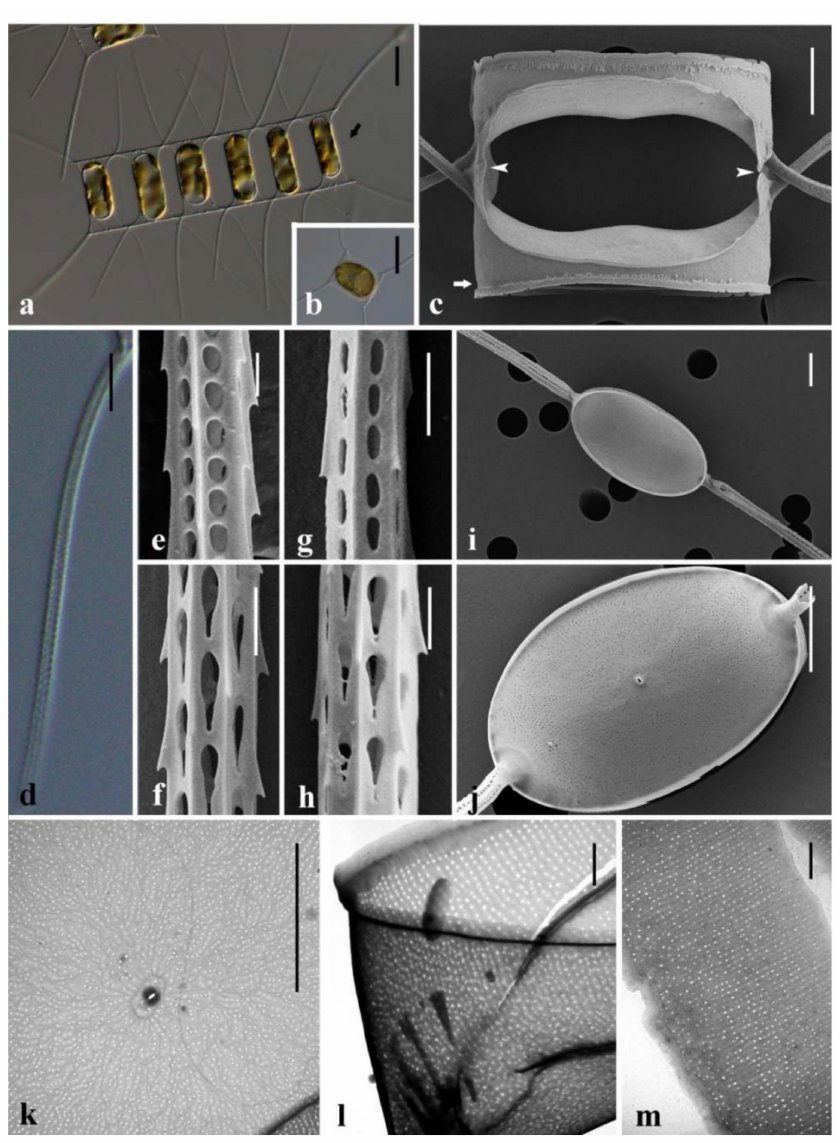
Figure 2. LM ( a , b , d ), SEM ( c , e – j ) and TEM ( k – m ) micrographs of vegetative cells of Chaetoceros macroelegans sp. nov., strain MC785. ( a ) Chains in broad girdle view, showing protrusions on terminal valve (arrow); ( b ) solitary cell; ( c ) sibling intercalary valves showing aperture, overlapping silica ear-like structures (arrowheads) and furrow above the basal ring of mantle (arrow); ( d ) terminal seta under LM, showing visible setae poroids; ( e – h ) setae structure, showing round-oval and tear- shaped poroids on terminal ( e , f ) and intercalary setae ( g , h ), respectively; ( i ) intercalary valve view; ( j , k ) terminal valves; ( l ) parallel rows of poroids on the mantle; ( m ) detail of bands. Scale bars: ( a , b ) 20 µ m; ( c , d , i – k ) 5 µ m; ( e – h , l , m ) 1 µ m. Diagnosis : Straight chains, sometimes solitary cells. Normally 4–10 chloroplasts in each cell. Apical axis 12.6–39.7 µ m. Pervalvar axis 11.3–28.4 µ m. Height of aperture 6.3–12.6 µ m. Rectangular cells in girdle view. Central annulus, radiating costae and scattered poroids on valve face and mantle. Elliptical–hexagonal apertures. Setae Brunel I type. Short setae base or absent. Sibling setae intersect outside chain border without fusing. Tear-shaped and round-oval poroids on intercalary and terminal setae. Tear-shaped poroids 0.7–2.3 µ m long on intercalary setae. Round-oval poroid density of 12–19 in 10 µ m on terminal setae, 15–18 in 10 µ m on intercalary setae. A single rimoportula with short external tube on the terminal valve. Several girdle bands marked by parallel rows of poroids and costae. Smooth